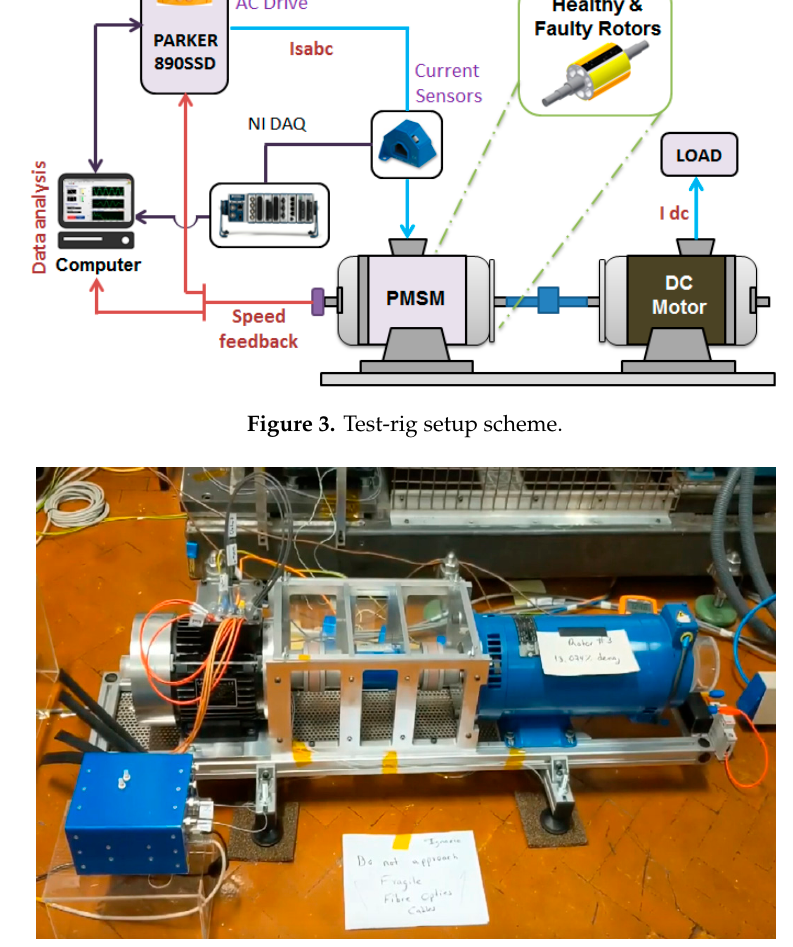
Figure 4. Test-rig setup. Figure 4. Test-rig